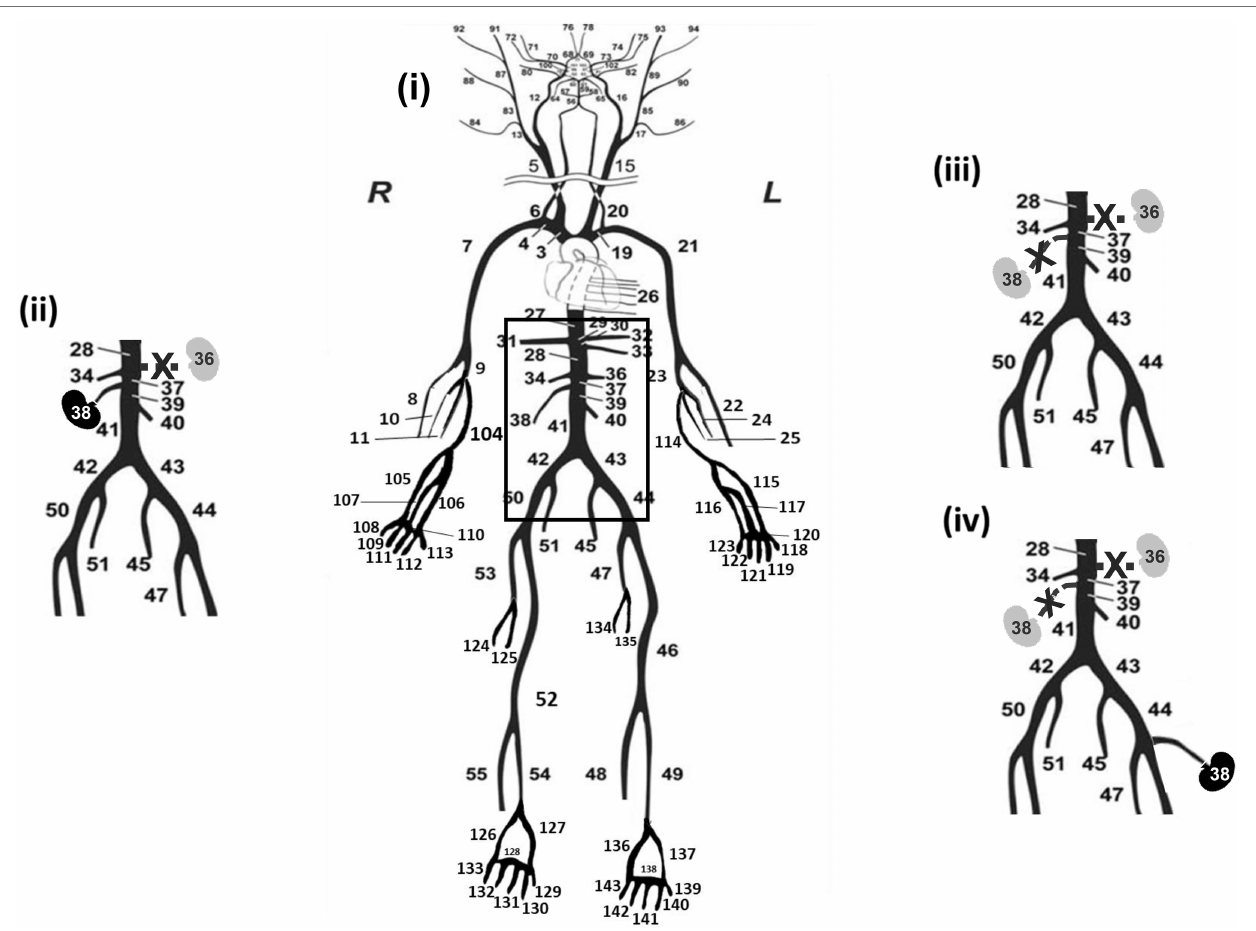
FIGURE 1 | Representation of the complete arterial topology (used in the computer model with the hand and foot topologies, adapted from Reymond et al., 2009). (i) Control with two kidneys configuration (2KDN), kidneys in their usual anatomical location on the aorta. (ii) One kidney configuration (1KDN), the left renal artery (segment 36) is disconnected from the model. (iii) Zero kidneys configuration (0KDN), simulated by removing both the right and the left renal arteries, segments 36 and 38. (iv) Transplanted configuration (TX), both renal arteries were disconnected, the right renal artery (segment 38) was attached into the external iliac artery (segment